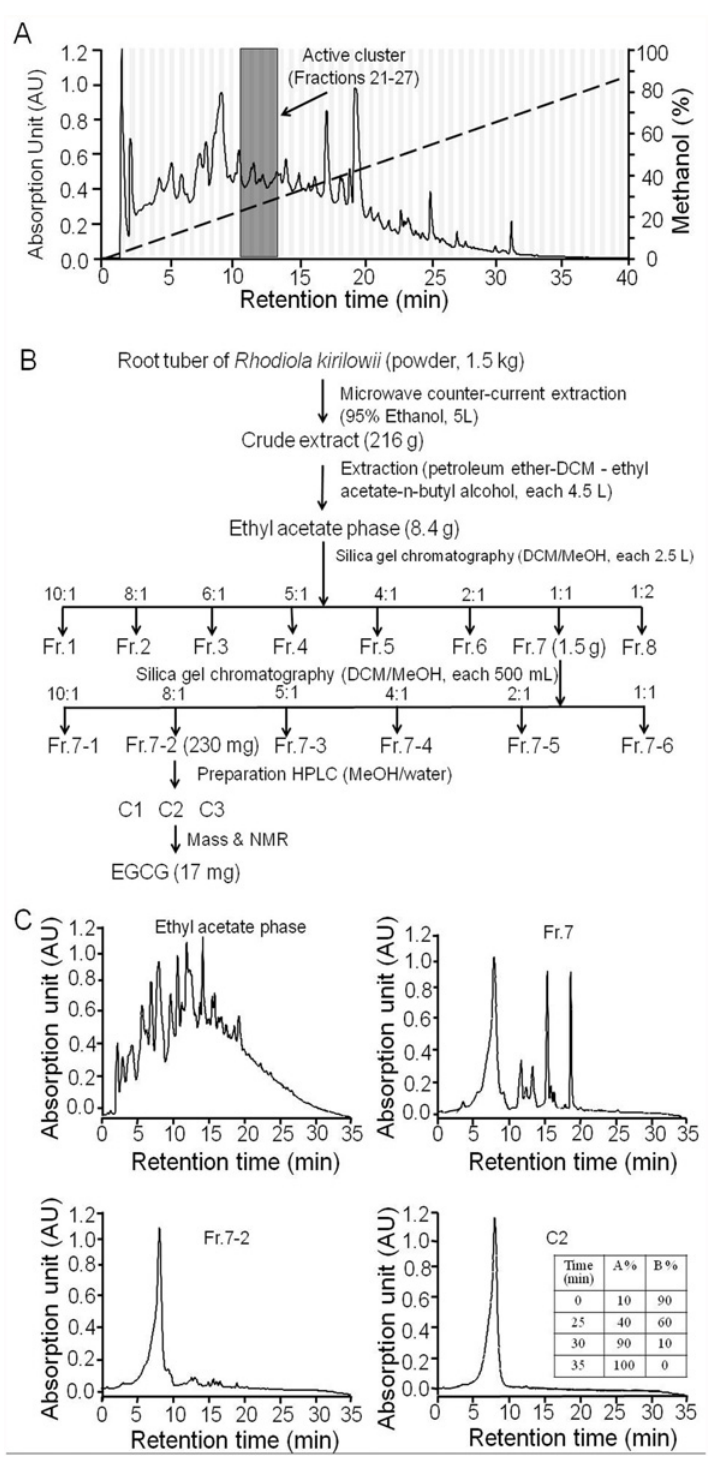
Fig 2. Fractionation of Rhodiola kirilowii (Regel) Maxim. A. HPLC fractionation of Rhodiola kirilowii (Regel) Maxim showing the chromatogram at 220 nm absorbance. Vertical bars show 80 collected fractions. B. Activity-directed fractionation scheme for the isolation CFTR inhibition compounds from Rhodiola kirilowii (Regel) Maxim. C. Analytical HPLC chromatograms of fraction ethyl acetate phase, Fr.7, Fr.7 – 2, and C2 at 220 nm absorbance. The gradient of analytical HPLC was developed with mobile phase A (acetonitrile) and mobile phase B (0.2% acetic acid) at 0.2 mL/min flow rate (inset)